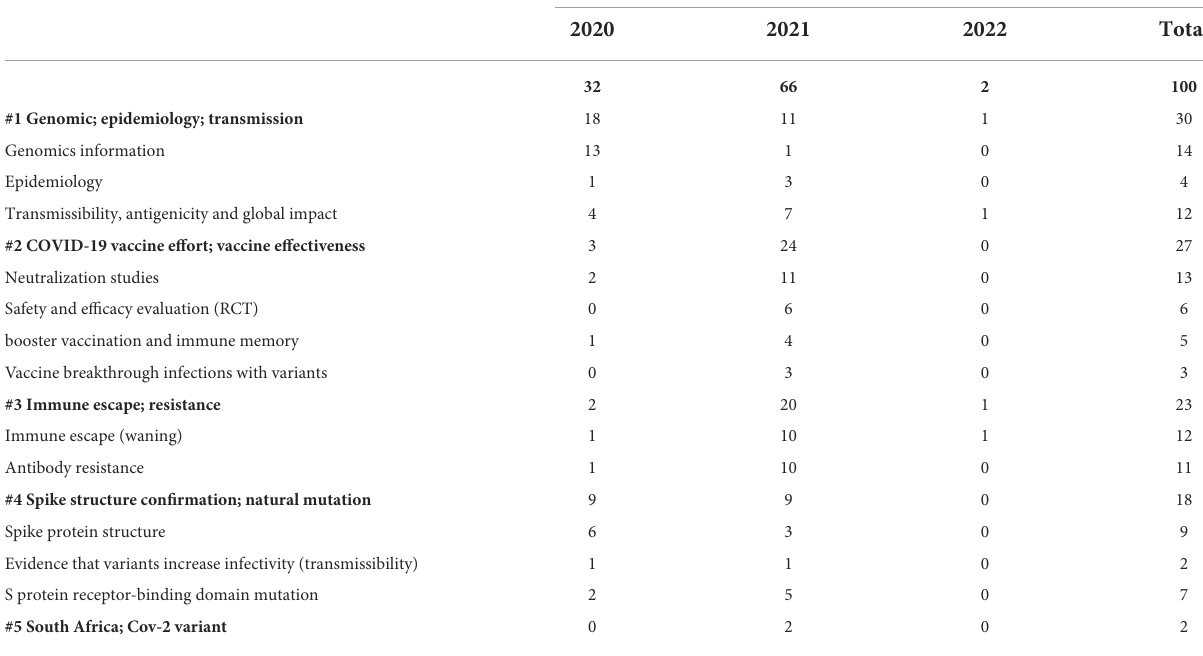
TABLE 4 Main topics covered in the 100 most-cited SARS-CoV-2 variants